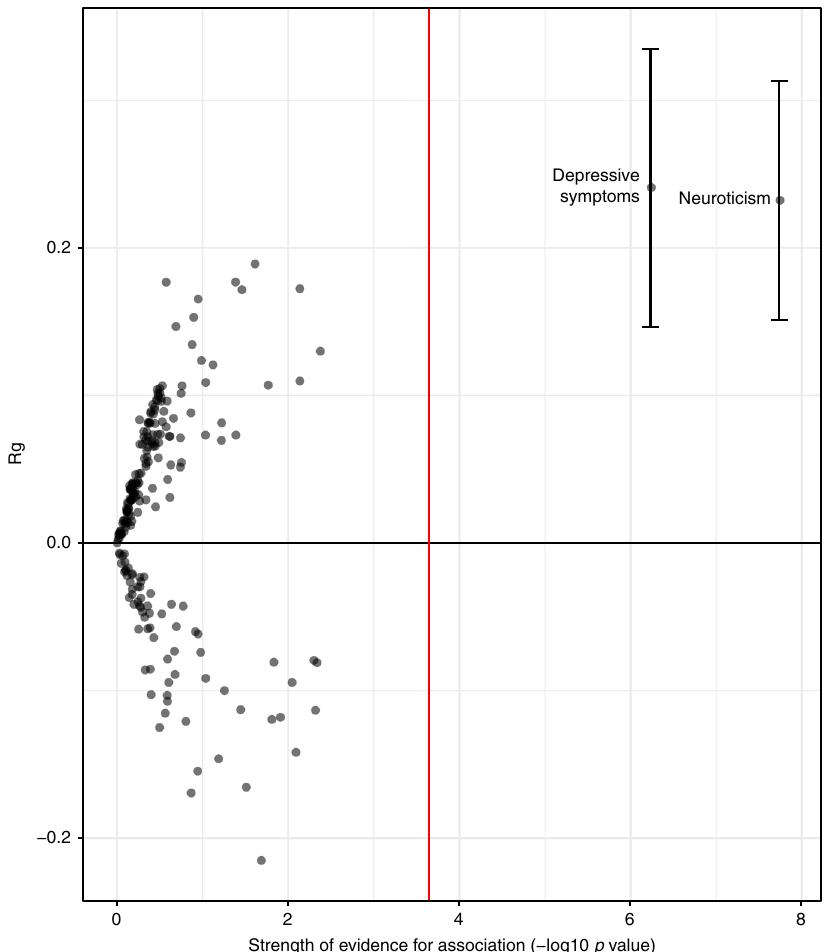
Fig. 4 Genetic correlation between mouth ulcers and 222 traits. Each dot represented the Rg between mouth ulcers and an individual trait. The red line represents the Bonferroni-corrected multiple testing threshold at the 5% level. Error bars showing 95% con fi dence intervals and labels are included for traits that pass the multiple testing